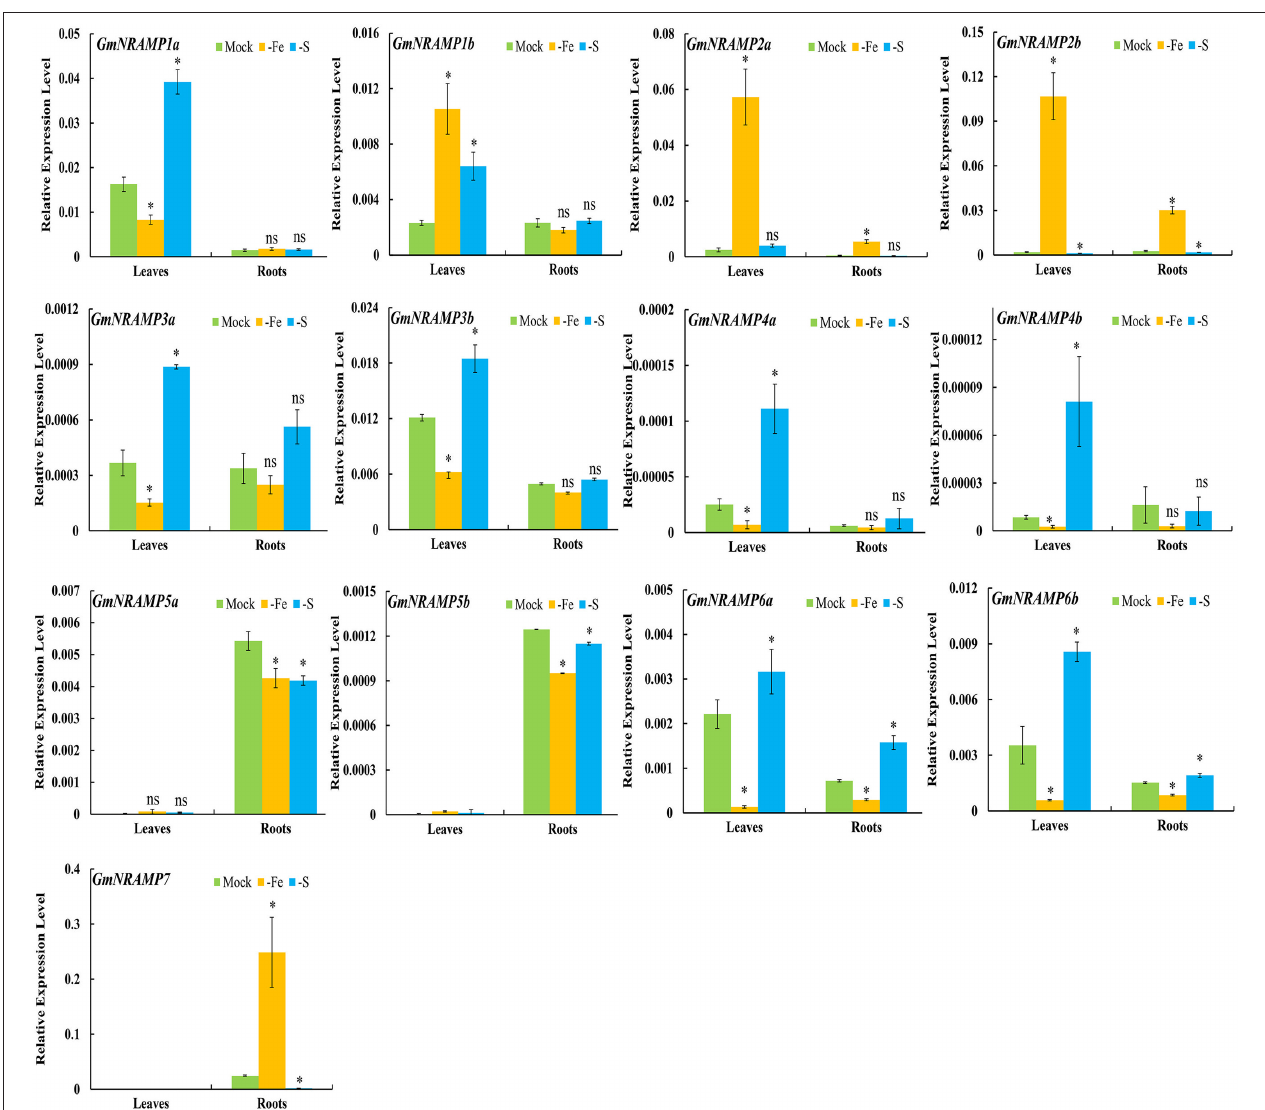
FIGURE 6 | Expression of GmNRAMPs in response to Fe or S deficiency. Ten-day-old soybean seedlings were subjected to Fe or S deficiency for 14 days. Leaves and roots were separately harvested for qRT-PCR analysis. Fold-changes of GmNRAMP gene expression were normalized against the reference gene TefS1 using 2- 1 Ct values. Each bar is the mean of four biological replicates with standard error. “*” indicates significant differences between soybean without and with rhizobia inoculation in young leaves, stems, and roots in one-way analysis of variance, * P < 0.05, ns: not